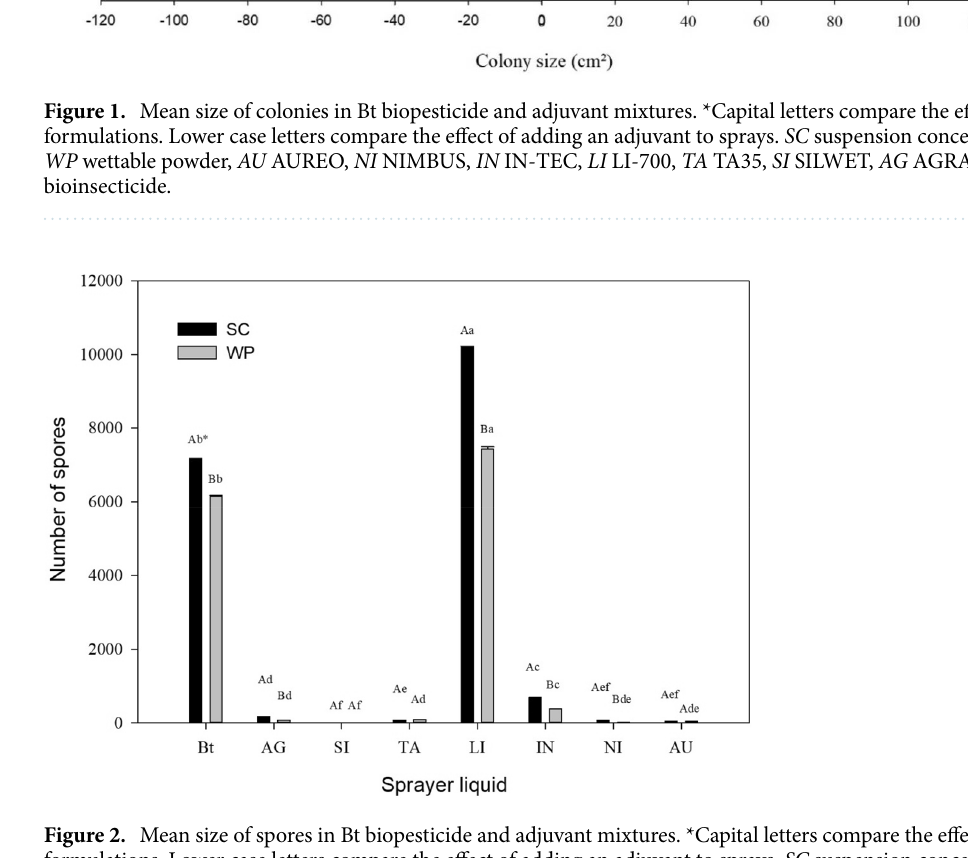
Figure 2. Mean size of spores in Bt biopesticide and adjuvant mixtures. *Capital letters compare the effect of formulations. Lower case letters compare the effect of adding an adjuvant to sprays. SC suspension